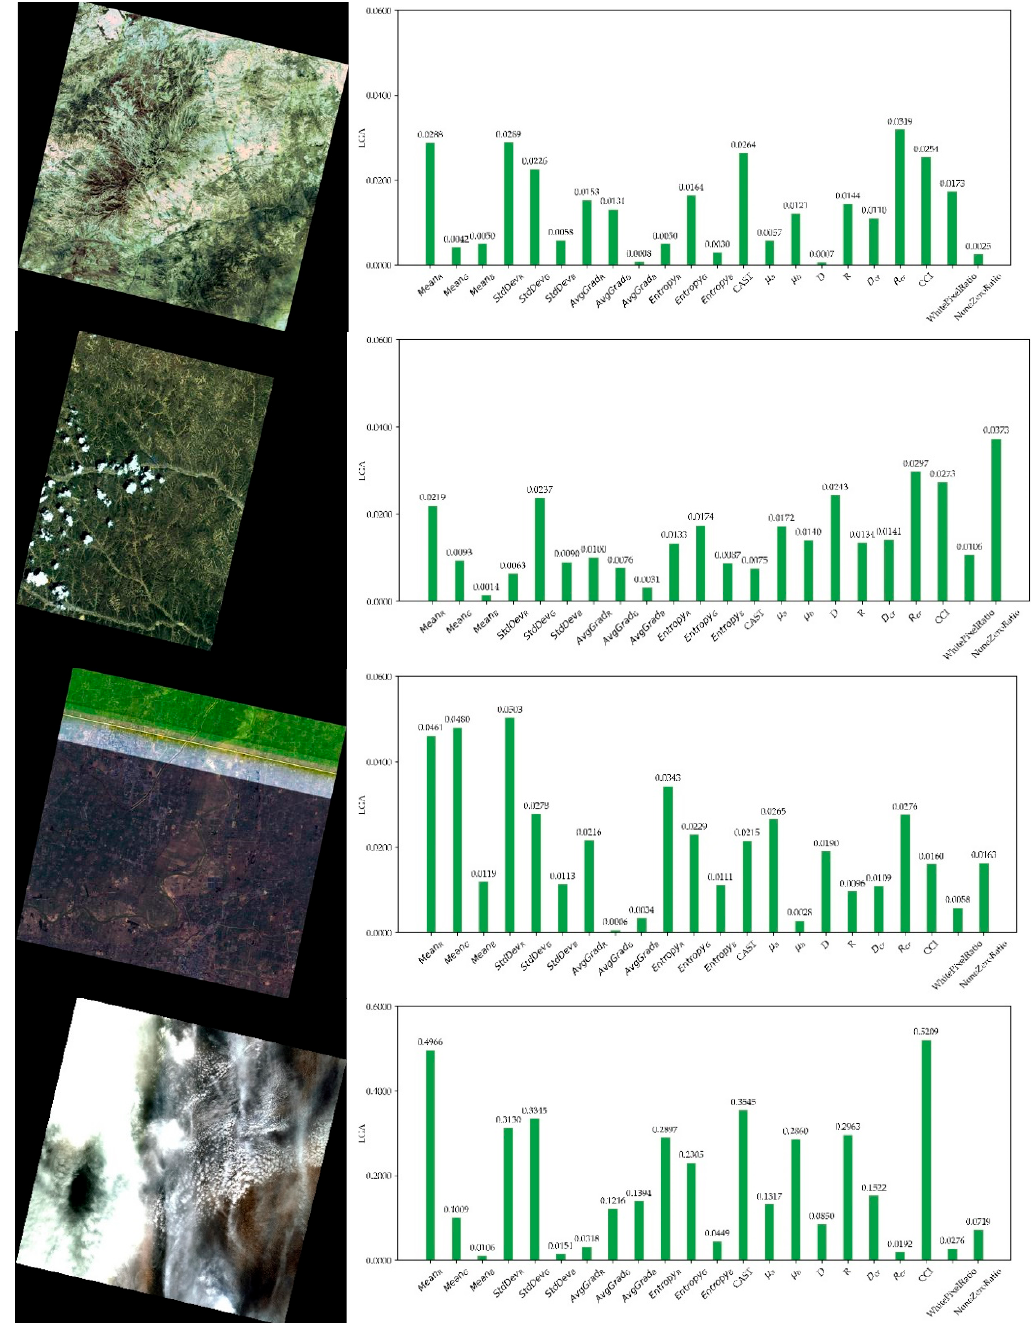
Figure 9. Results of LGA. Best viewed in color. Four satellite images on the left and LGA results on the right. All the four images are labeled abnormal by the model.